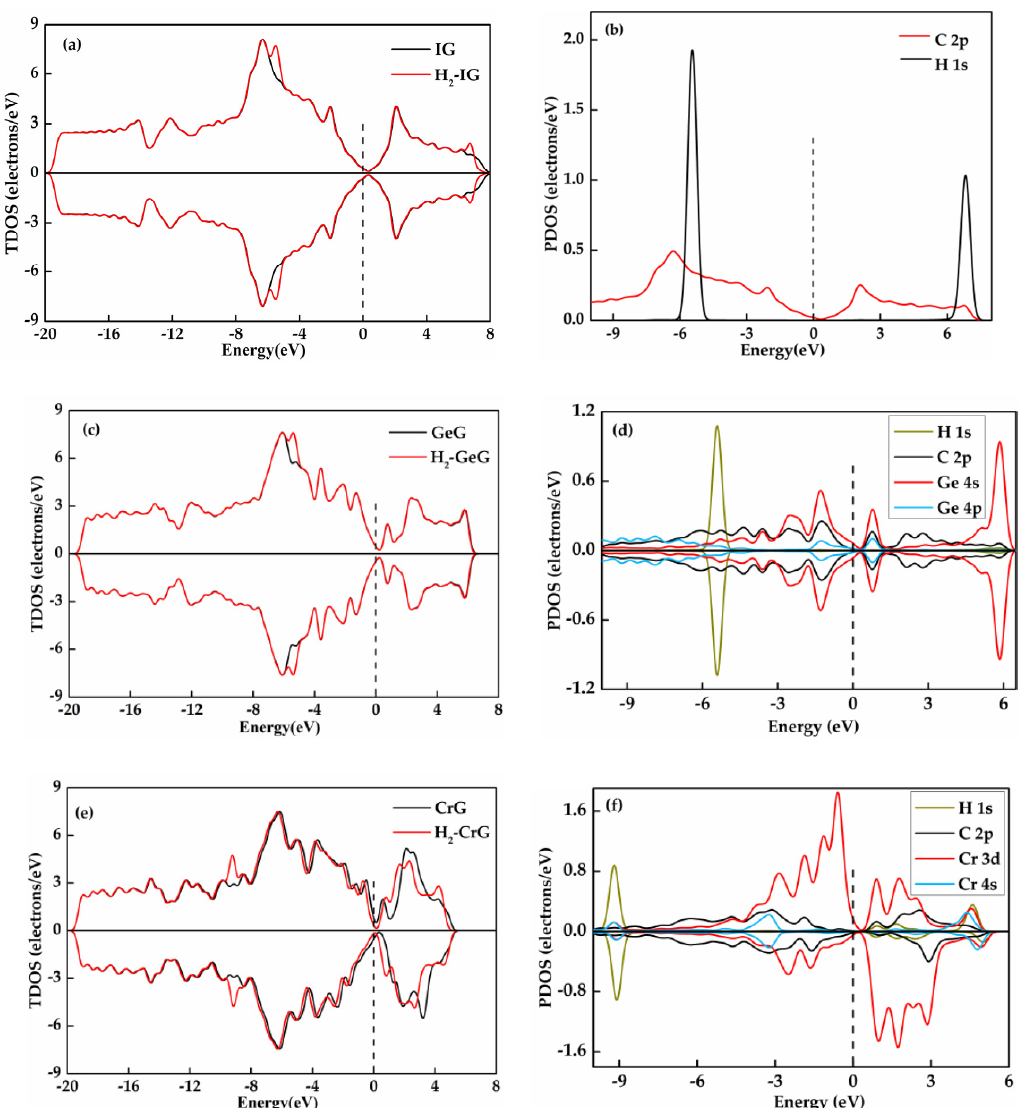
Figure 8. The TDOS and PDOS of H 2 adsorbed on IG ((a), (b)), GeG ((c), (d)), and CrG ((e), (f)). Figure 9 displays the charge density difference of the CrG system, and the getting and losing of the electron can be seen in the red and blue areas, respectively. H 2 molecule and Cr atom are surrounded by blue and red, respectively, which indicates that Cr atom obtains electrons from the H 2 molecule. This phenomenon further confirms that charges transfer from H 2 molecule to CrG, which is uniform with the results of the Q t (0.052 e). In addition, a certain amount of interaction exists because of the continuous electron area between H atom and Cr atom.